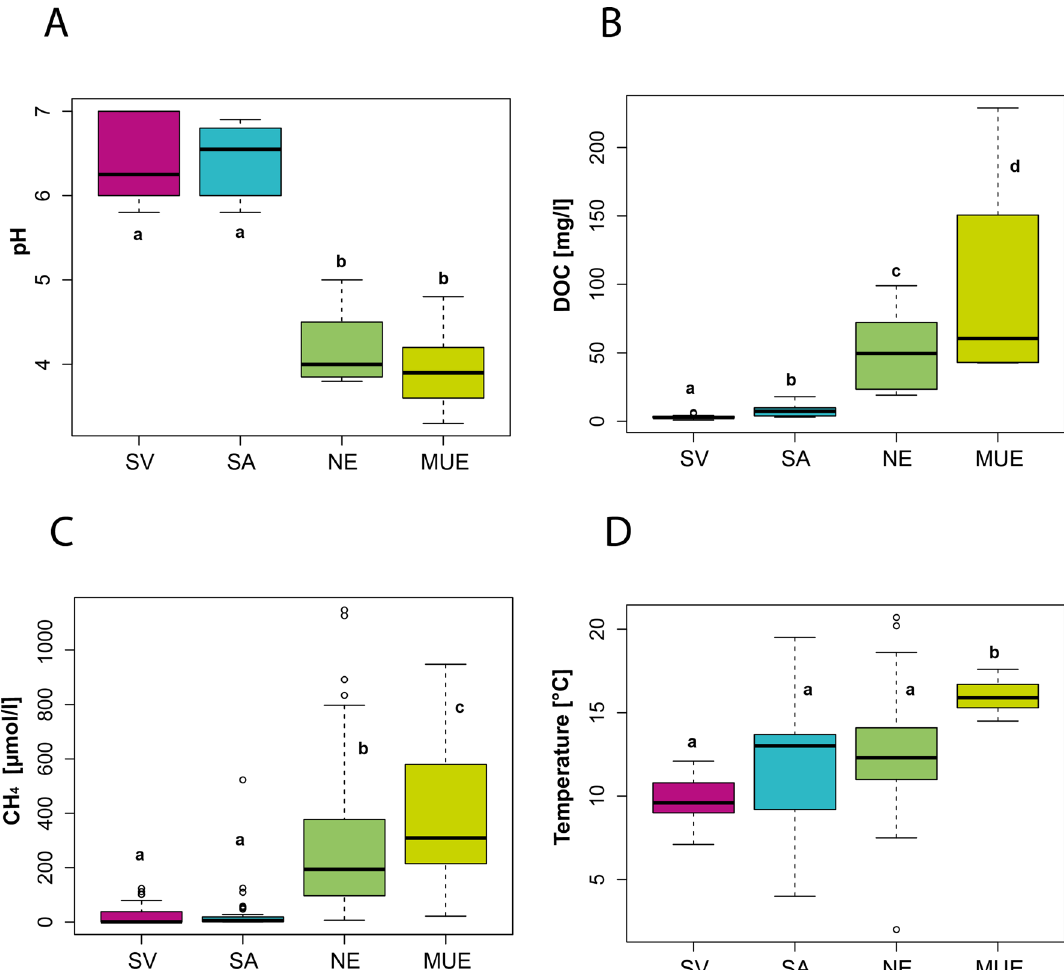
Figure 2. Box plots showing the measurements of selected environmental variables. ( A ) pH, ( B ) dissolved organic carbon (DOC), ( C ) methane and ( D ) temperature of all subsites in Svalbard (SV, magenta), Samoylov (SA, blue), Neiden (NEI, dark green) and Mueritz (MUE, light green). Pairwise t-tests suggest that samples with different letters show a significant (p < 0.05) difference in the mean value between each